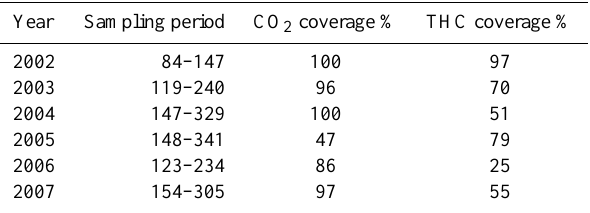
Table 1. Sampling period for each year presented as day of year (DOY) for the first and last day of sampling. CO 2 and THC cover- age indicates number of days in % when data are available during the sampling period. CO 2 and THC denote carbon dioxide and total hydrocarbon